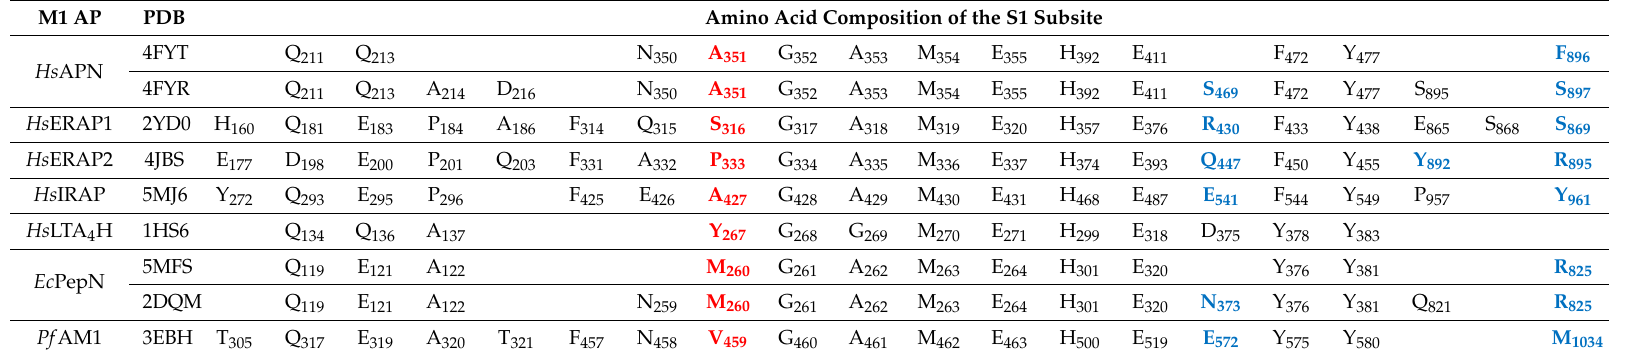
Table 5. Amino acid composition of the S1 subsite of selected M1